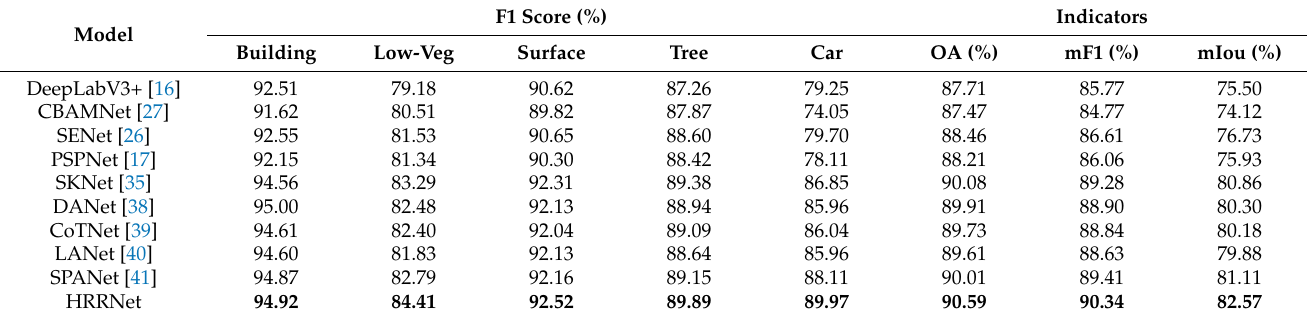
Table 5. Experimental results for various models (on Vaihingen data), the optimal results are bolded. Model